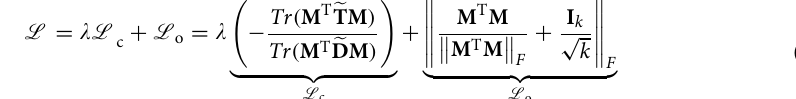
Figure 8. The architecture of gmcNet. X R n X m ′ is CEPR-embedded feature with m × ¯ ∈ genes to k modules. L is loss